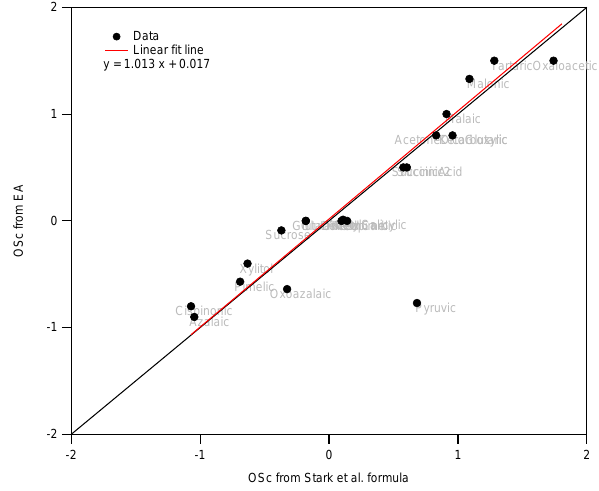
Figure 16. Carbon oxidation state of various organic compounds calculated from elemental analysis compared to the estimates using the Stark et al. (2015)